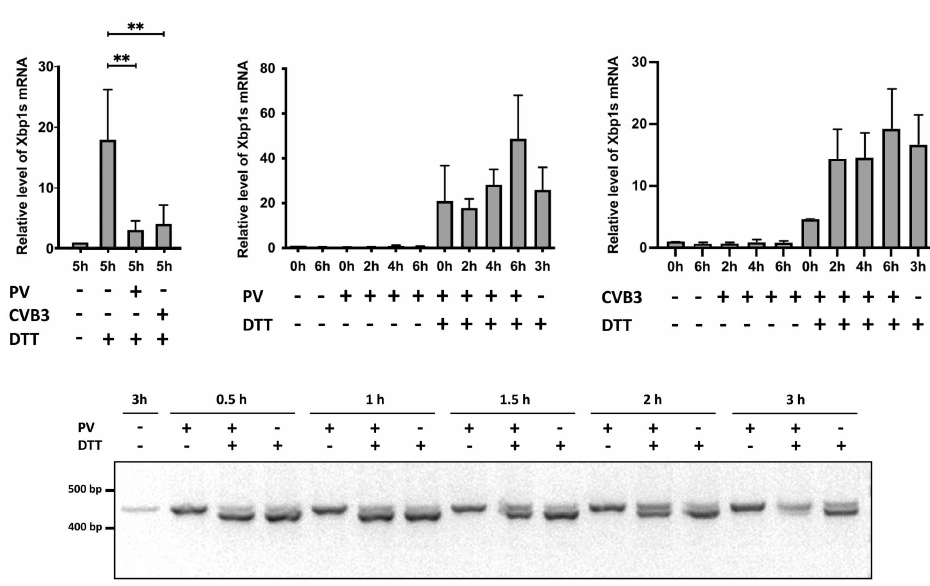
Figure 5. Enteroviruses inhibit Ire1-mediated Xbp1 mRNA splicing at the middle, but not early stage of infection. ( A ) HeLa cells were infected with PV or CVB3, then at 3 hpi 10 mM DTT was added to the medium. 2 h later, total RNA was isolated and the relative levels of the spliced Xbp1 mRNA were measured by RT-qPCR, as described earlier, ** p < 0.01. ( B ) Relative Xbp1s mRNA level in PV-infected HeLa cells with and without the addition of 10 mM DTT at 0 hpi, as revealed by RT-qPCR. ( C ) The same experiment as in ( B ), with CVB3. Each experiment was performed in duplicate and repeated at least three times. ( D ) DTT-induced Xbp1 mRNA splicing in PV-infected cells analyzed by agarose gel electrophoresis of RT-PCR products. HeLa cells were infected with PV and treated with 10 mM DTT at the indicated time points. 2 h later, cells were harvested, RNA was extracted, and RT-PCR with an Xbp1-specific primer pair producing fragments of either 442 or 416 bp (corresponding to the unspliced or spliced Xbp1 mRNAs, respectively) was performed. Note that the amounts of the two PCR products should not be compared to each other, as they have different